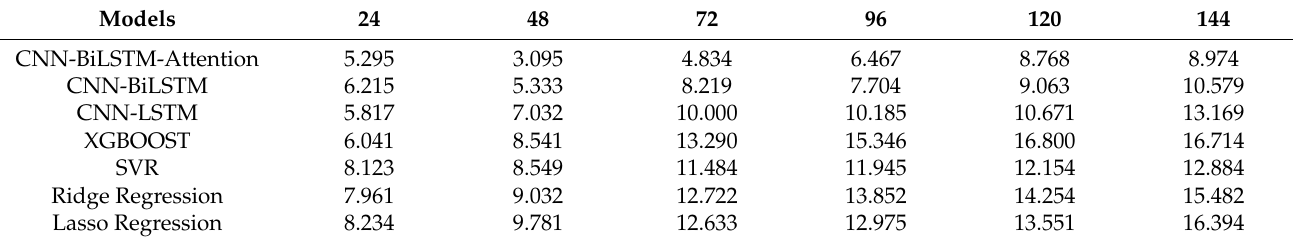
Table 7. RMAE for long-term prediction of each model (Unit: µ g/m 3